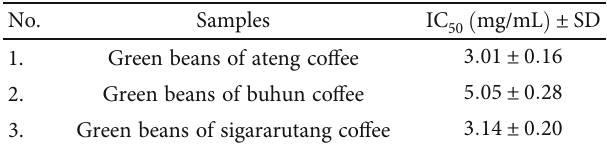
Table 3: IC values of alpha-glucosidase inhibitory activity of the 50 co ff ee